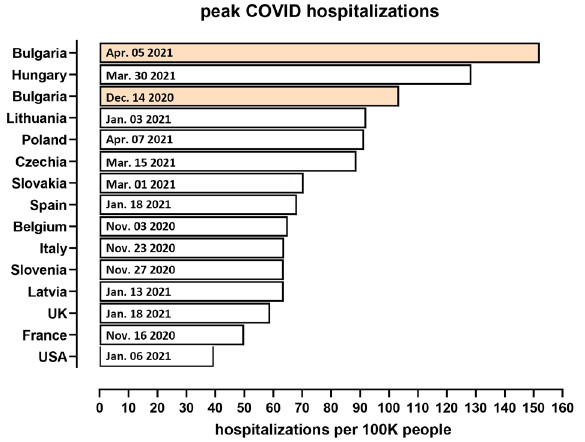
Figure 9. Peak hospitalizations in Bulgaria and other countries from the beginning of the pandemic till April